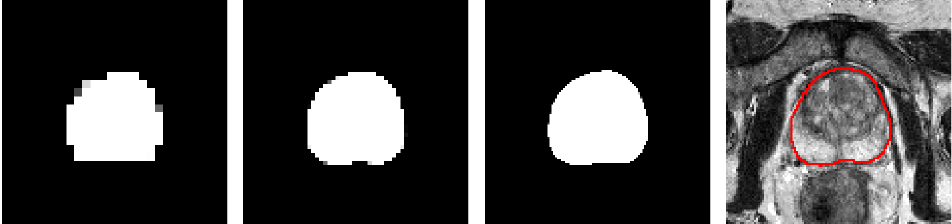
Figure 3. From left to right: first intermediate prediction, second intermediate prediction, third (and final) prediction, and original MR prostate image with GT